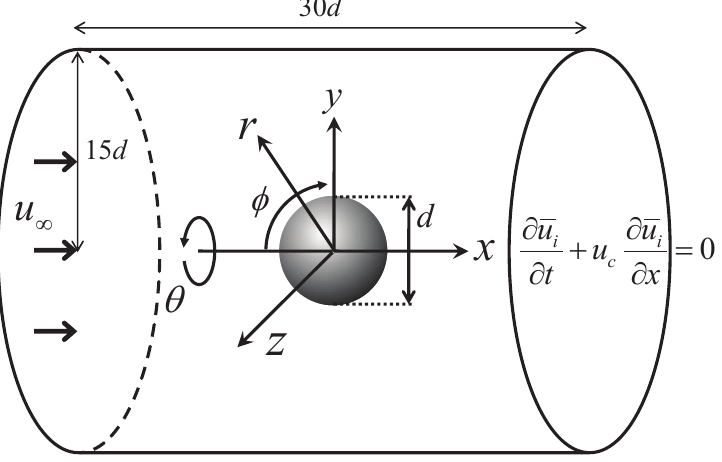
Figure 2. Coordinate system, computational domain and boundary conditions.